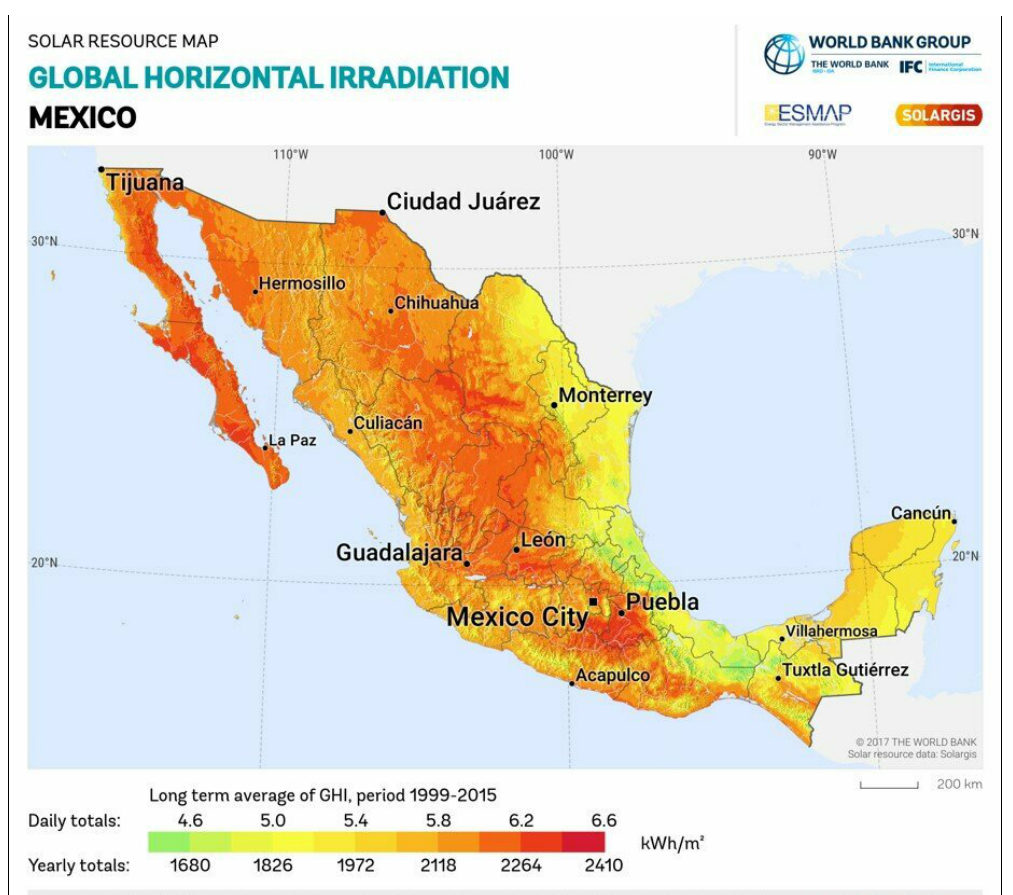
Figure 2. The Mexican solar radiation atlas